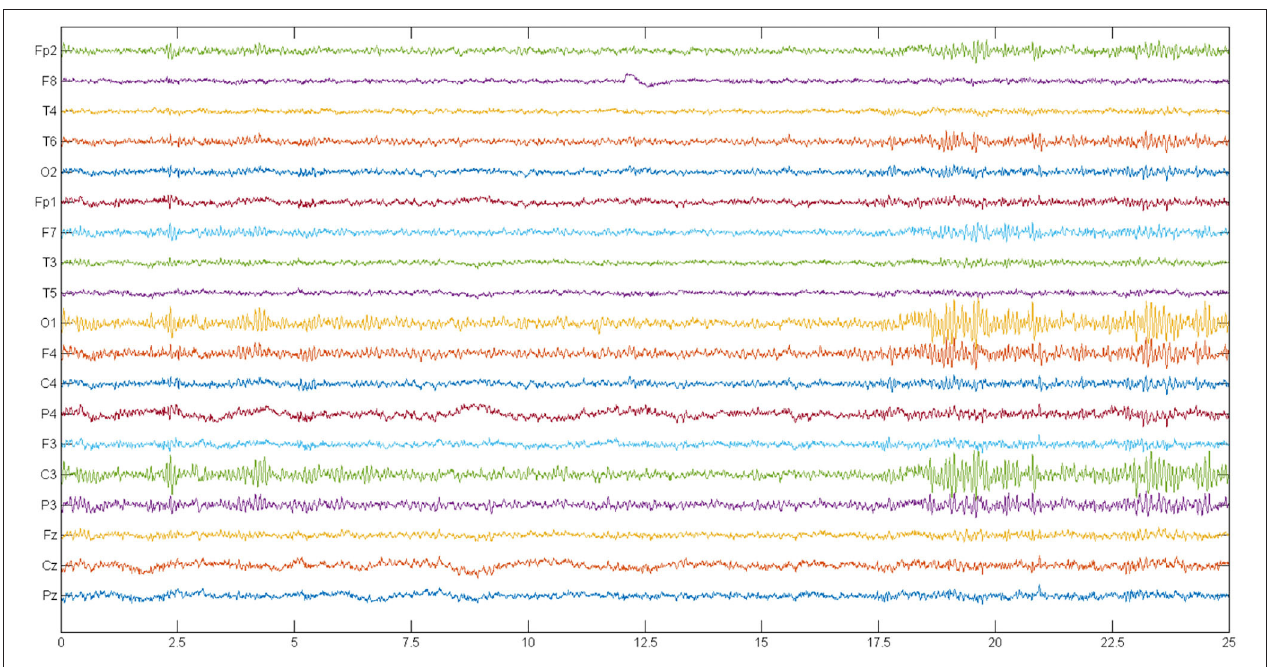
FIGURE 3 | A sample frame of the EEG signals of a normal person. EEG, electroencephalograph.